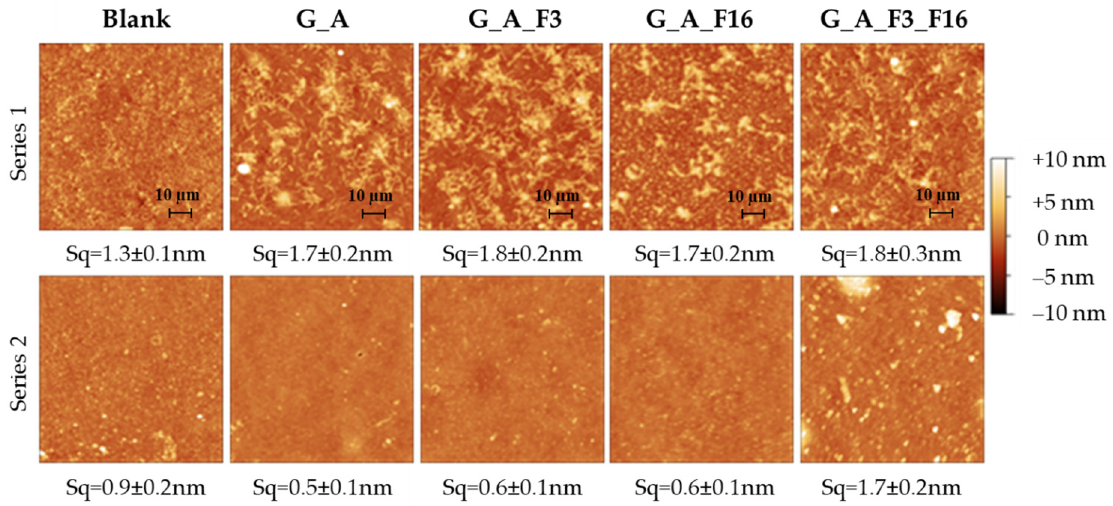
Figure 7. Representative AFM images of bare and functionalized glass substrates (all images are 2 × 2 µm, series 2 differs from series 1 for the presence of an additional applied coating layer).